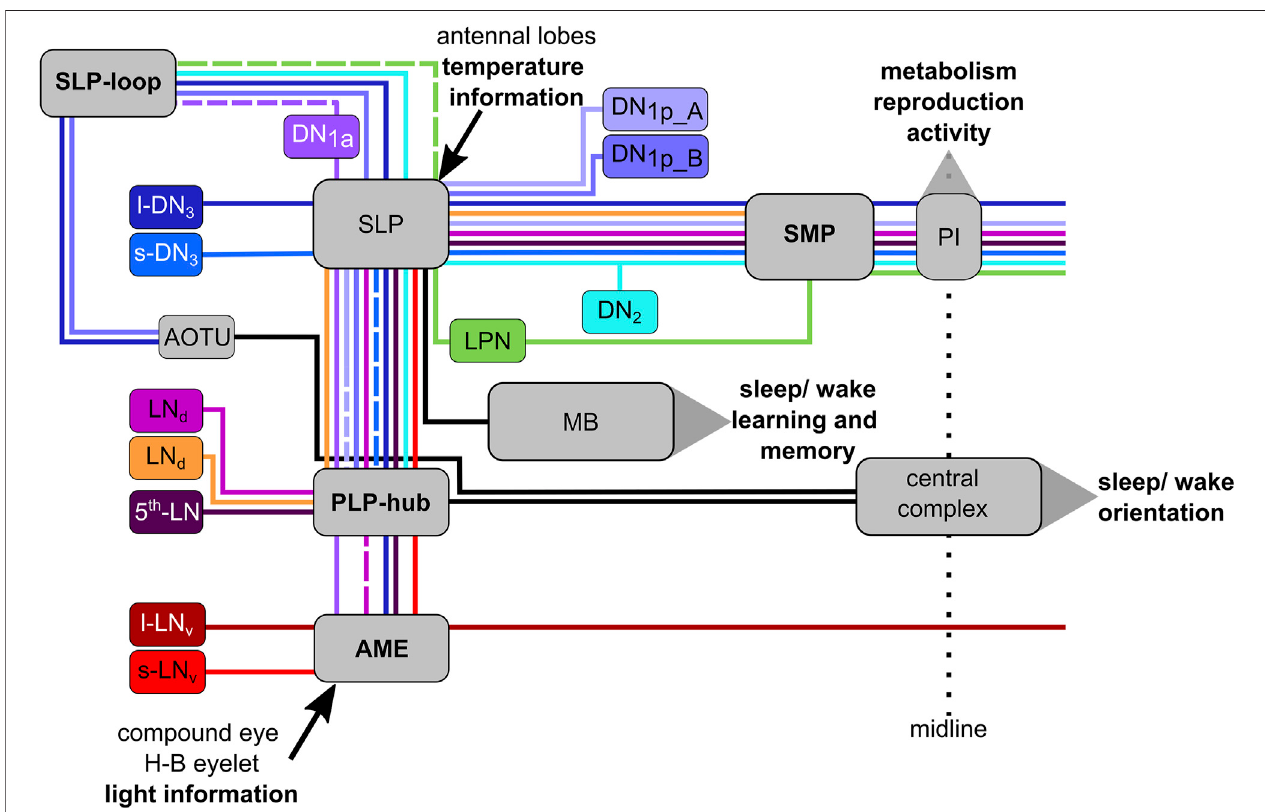
FIGURE 15 | Schematic overview of the Drosophila clock network in the left hemisphere including input and output sites. The major groups of clock neurons and theircorrespondingprojectionsaredepictedincolor,whilethebrainregionstheyinvadeareshowningrey.Boldlettershighlightmajorhubsandtracts,inwhichthe fi bers ofseveralclockneuronsintermingleandcontacteachother.Thesearethe “ accessorymedulla ” (AME),thenewlydiscovered “ posteriorlateralprotocerebrumhub ” (PLP- hub),the “ superiorlateralprotocerebrumloop ” (SLP-loop)andthe “ superiormedialprotocerebrum ” (SMP).Dashedcoloredlinesindicatethatnotallneuronsofthe relevant group show the drawn projections. Besides the intrinsical light-sensitivity of some clock neurons ( via CRY), the clock network receives light input from the compound eyes and the Hofbauer-Buchner (H-B) eyelets in the AME, while it receives temperature information solely from peripheral sensory organs in the chordotonal organs antennae and antennal lobes in the “ superior lateral protocerebrum ” (SLP). Output from the clock network to control rhythms in metabolism, reproduction and activity occurs in the “ pars intercerebralis ” (PI), while the rhythmic control of the sleep/wake cycle occurs via connections to the mushroom bodies (MB) and the central complex. The MBs ful fi ll additional functions such as learning and memory that are also modulated by the clock network. The central complex consists of the protocerebral bridge, the fan-shaped body, the ellipsoid body and the noduli and has additional important roles in orientation and navigation. Flying straight for several hours needs the input from the clock to compensate for the movements of the sun across the sky. This input may come via the DN 1p _B (also called anteriorly projecting DN 1p ) and the DN 3 with large somata (l-DN 3 ) that run to the anterior optic tubercle (AOTU). The anterior tubercle neurons are connected with the ring neurons of the central complex of which some are involved in orientation and others in sleep. Certain neurons of the fan-shaped body have synaptic contact with clock neurons in the PLP hub and by this way may carry rhythmic information into the central